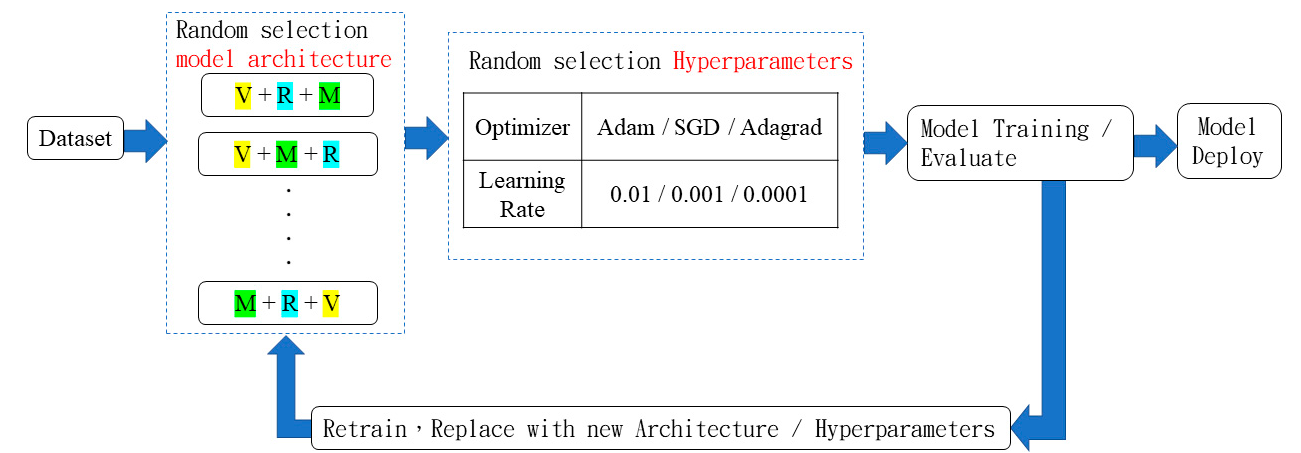
Figure 12. Operation of designed AutoML model.